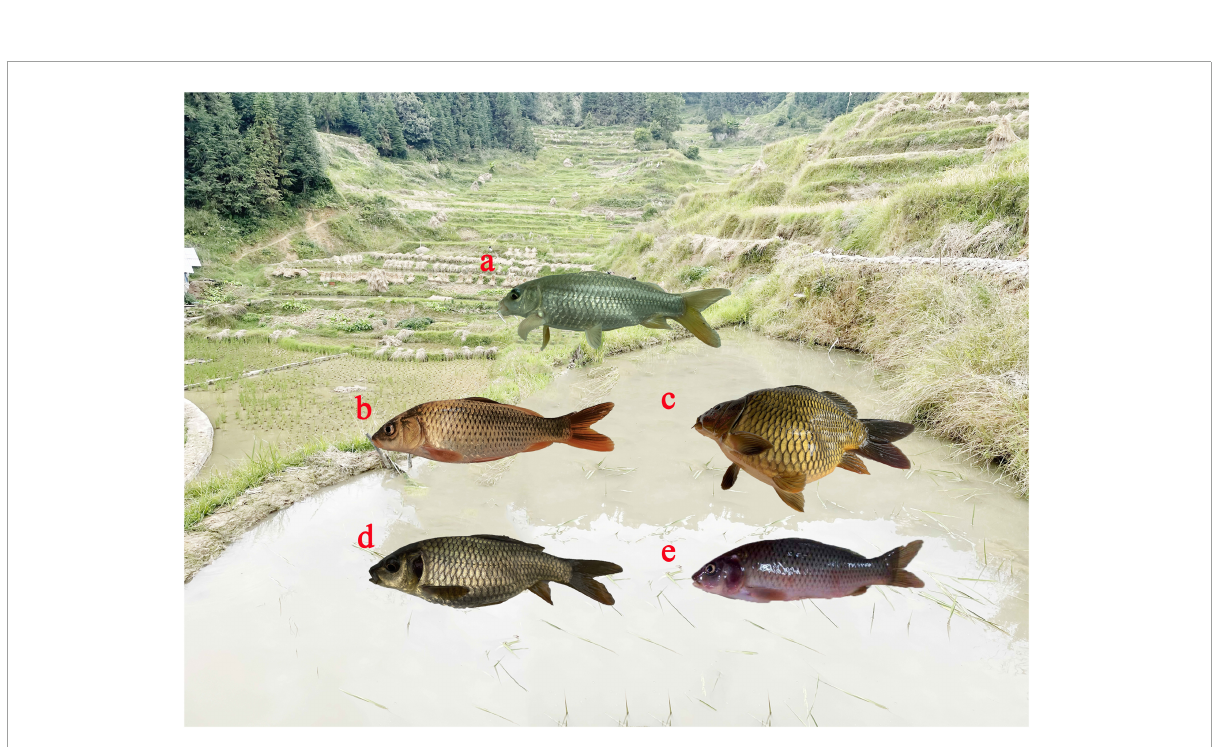
FIGURE2 Morphology of five PF-carp strains of (a) Daotian carp, (b) Jinbian carp, (c) Ruyuan No. 1, (d) Shaijiang carp, and (e) Wu